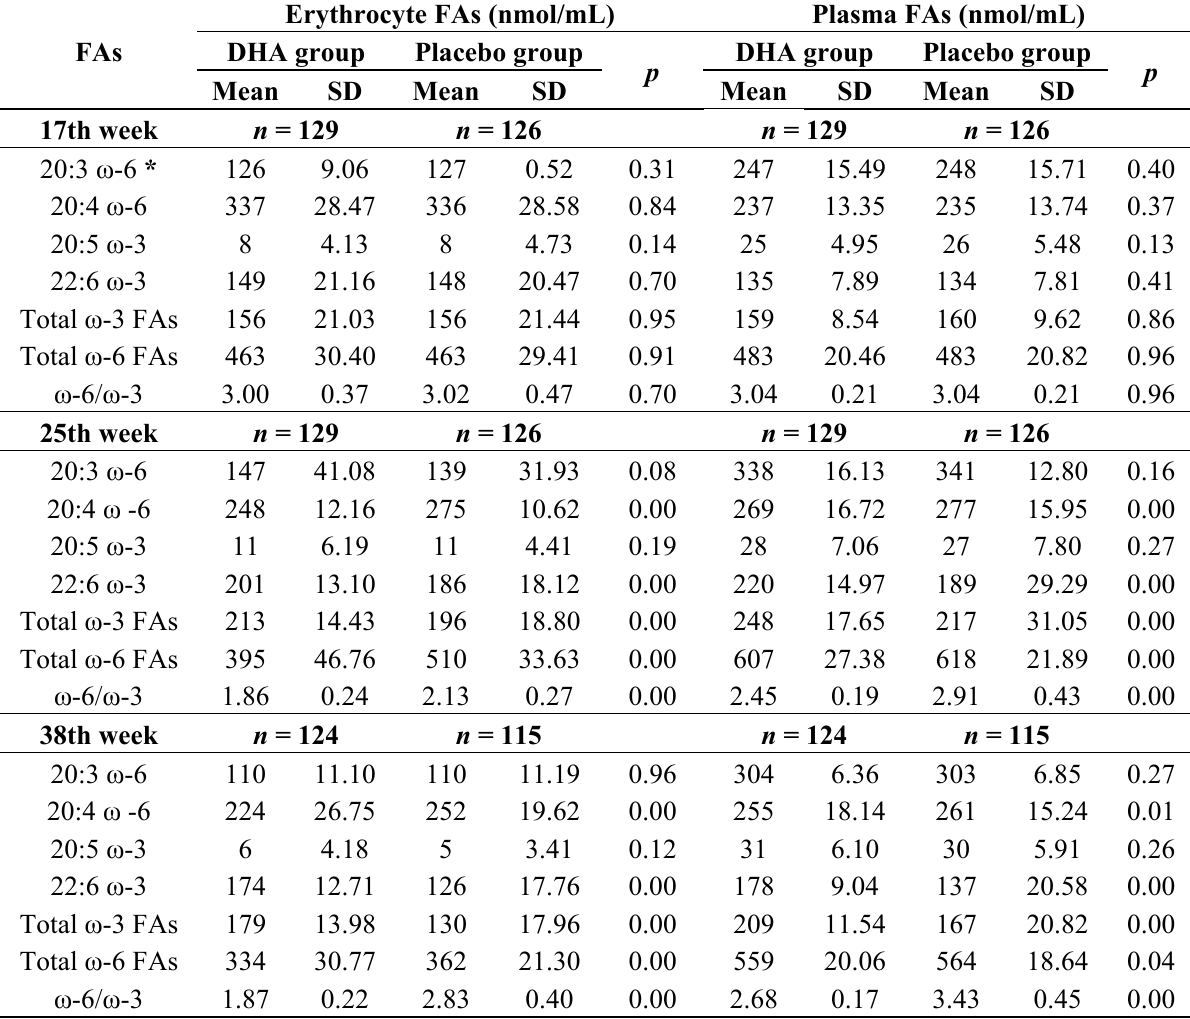
Table 2. Erythrocyte and plasma levels of ω -3 and ω -6 FAs at 17, 25 and 38 gestational weeks. Erythrocyte FAs (nmol/mL) FAs